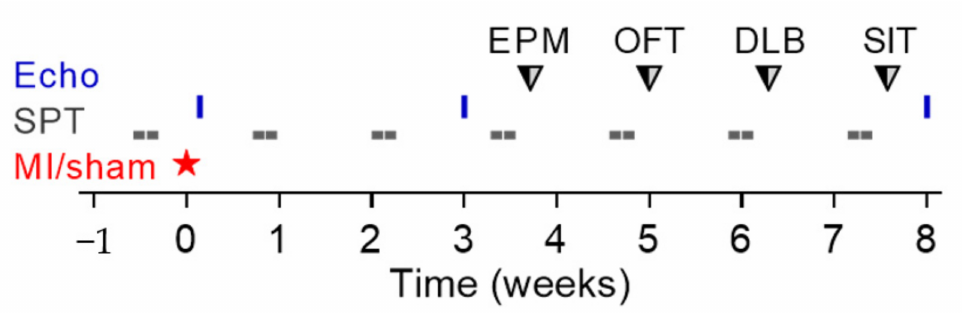
Figure 1. Experimental timeline of the long-term study. MI, myocardial infarction; Echo, echocardio- graphy; SPT, sucrose preference test; EPM, elevated plus maze; OFT, open field test; DLB, dark-light box; SIT, social interaction